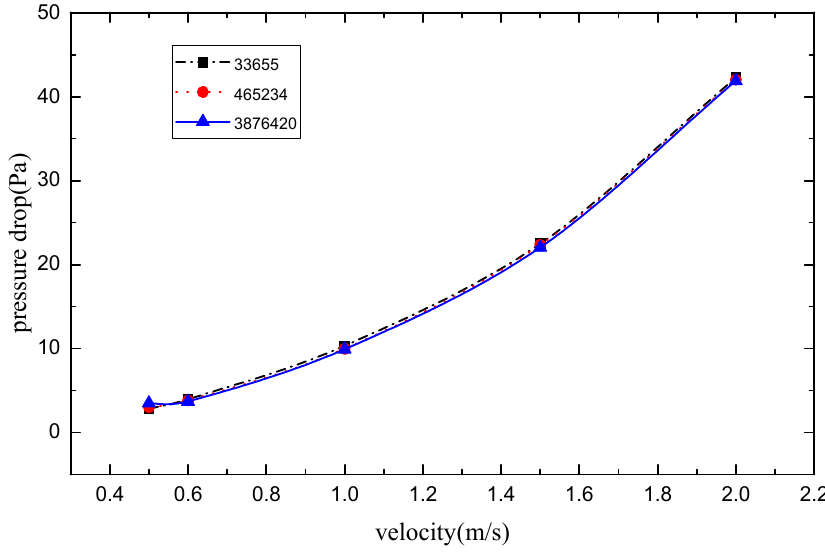
Figure 3. Grid independence verification results.